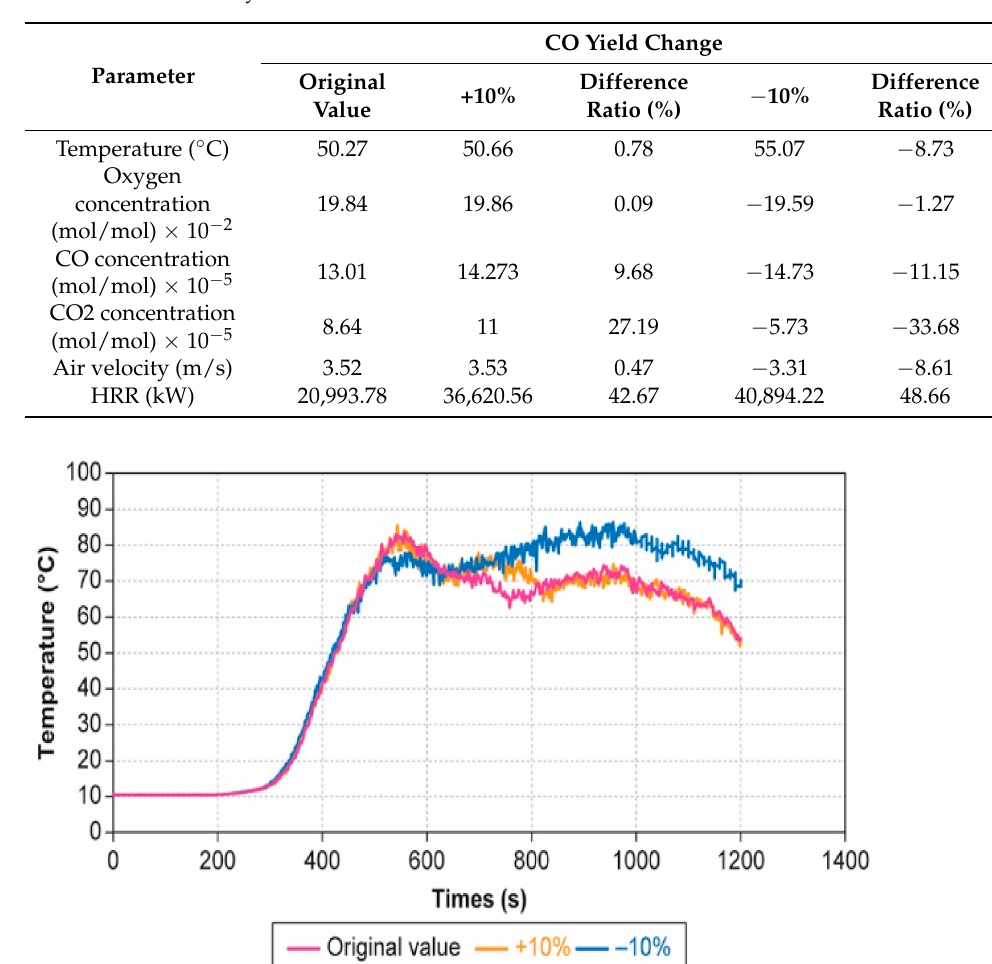
Table 9. Effects of CO yield.